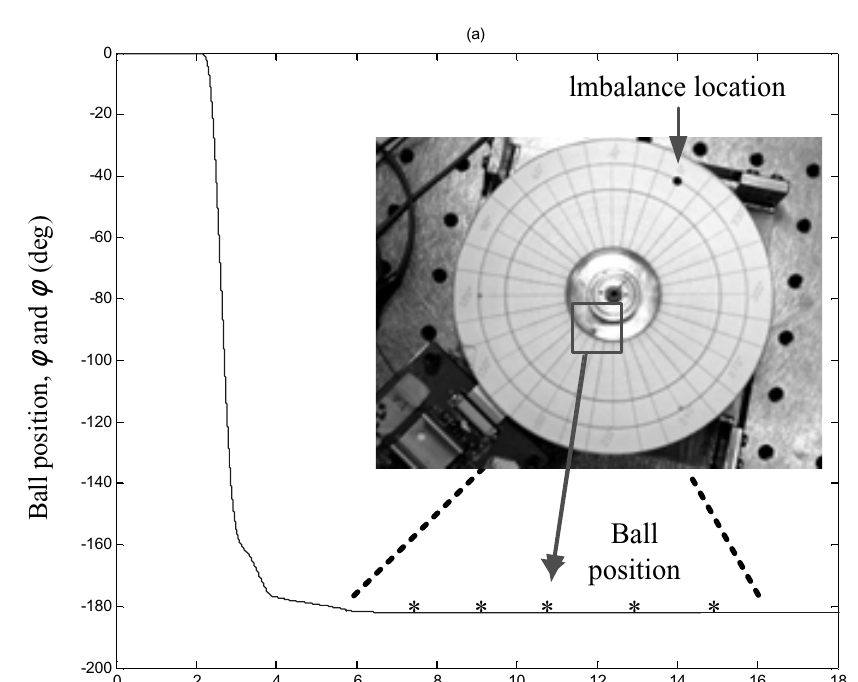
Fig. 13. Experimental setup.